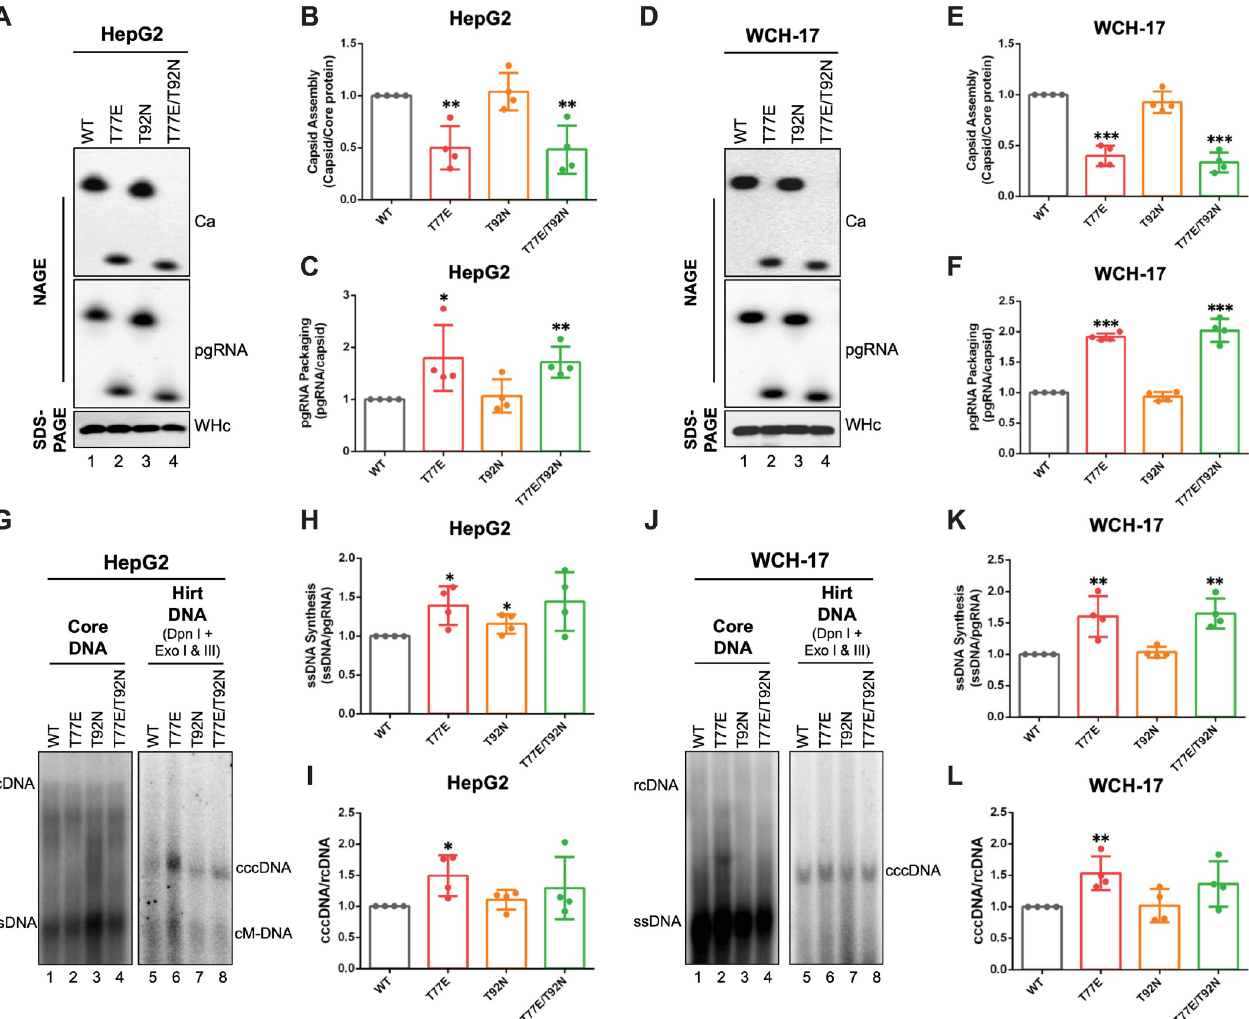
Fig 3. Effects of eliminating N-glycosylation sequons on WHc functions. The WHV replicon construct expressing the T77E, T92N, or T77E/T92N WHc mutants, or WT WHc was transfected into HpeG2 or WCH-17 cells. (A) The assembled capsids (top) and packaged pgRNA (middle) were detected by the C33 anti-HBc/WHc mAb and anti-sense WHV RNA probe, respectively, following the resolution of cytoplasmic lysates from the transfected HepG2 cells by native agarose gel electrophoresis (NAGE) and transfer to nitrocellulose membrane. Levels of WHc proteins (bottom) were measured by western blot using 19C18 anti-HBc/WHc mAb after SDS-PAGE. Capsid assembly efficiency (B) was determined by normalizing the levels of capsids to those of total WHc protein, and pgRNA packaging efficiency (C) was determined by normalizing the levels of pgRNA to those of capsids, with the efficiencies of WT WHc set to 1.0. (D)-(F) Cytoplasmic lysates from WHV replicon transfected WCH-17 cells were analyzed for capsid assembly and pgRNA packaging, as described for HepG2 cells. (G) WHV core DNA was released from the NCs of cytoplasmic lysate by SDS-proteinase K treatment and detected by Southern blot analysis. WHV PF-DNA was extracted from the transfected cells by the Hirt extraction method. The extracted DNA was treated with Dpn I plus the exonucleases I and III (Exo I & III) to remove all DNA with free 3’ ends. The ssDNA synthesis efficiency (H) was determined by normalizing the levels of ssDNA to those of pgRNA in ( A ), and the cccDNA formation efficiency (I) was determined by normalizing the levels of cccDNA to those of rcDNA in (G) , with the efficiencies of WT WHc set to 1.0. Similarly, core DNA and PF-DNA from WHV replicon transfected WCH-17 cells were analyzed (J)-(L) . Data is shown as mean ± SD. Two-tailed unpaired Student’s t test was used to compare the difference of each dataset versus WT WHc ( � , p < 0.05; �� , p < 0.01; ��� , p < 0.001). Ca, capsid; pgRNA, pregenomic RNA; WHc, WHV core protein; ssDNA, single-strand DNA; rcDNA, relaxed circular DNA; cccDNA, covalently closed circular DNA; cM-DNA, closed minus strand